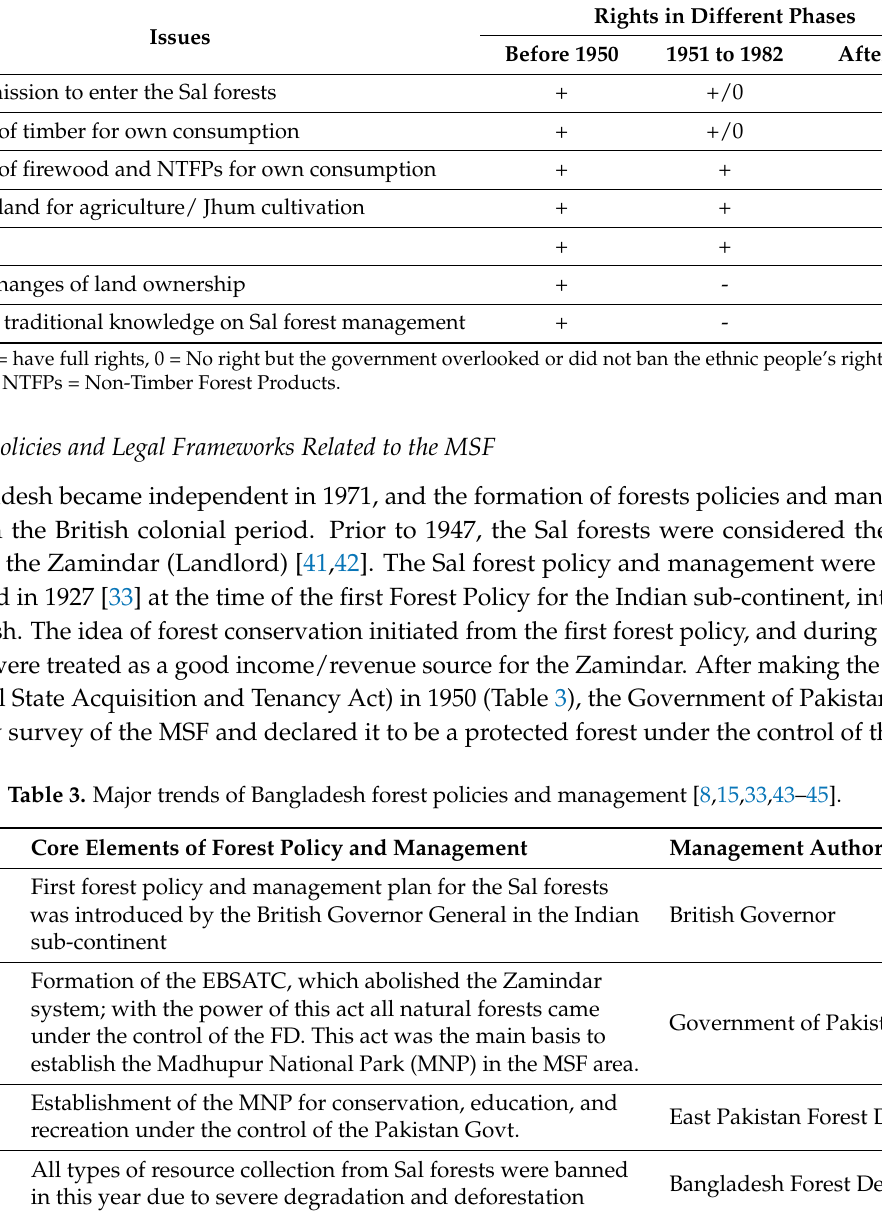
Table 2. Timeline of different rights of ethnic minorities over the Madhupur Sal forest. Rights in Different Phases Issues Before 1950 1951 to 1982 After